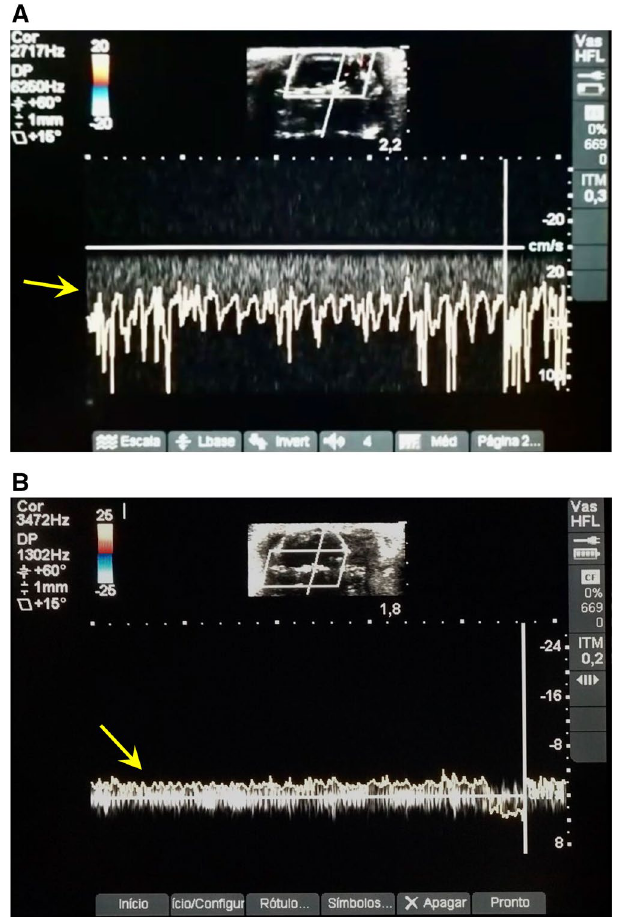
Figure 1. Ultrasound imaging and flow changes of the cerebral arteries measured in a cross-sectional direction. ( A ) Ultrasound imaging assessments before brain death induction. Note the presence of blood flow in the reverse direction (arrow). ( B ) Ultrasound imaging assessments 6 h after brain death induction. Note the blood flow compatible with brain blood circulatory collapse